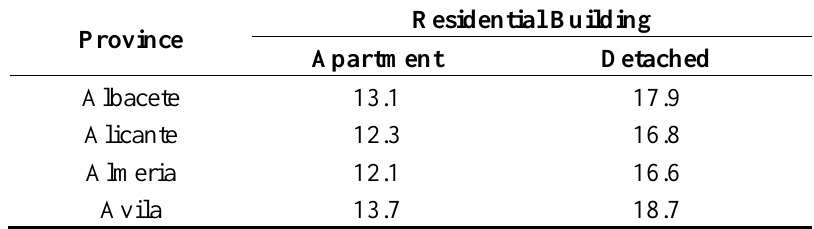
Table 8. Coefficients to estimate electrical energy consumption (kWh/m 2 per year).